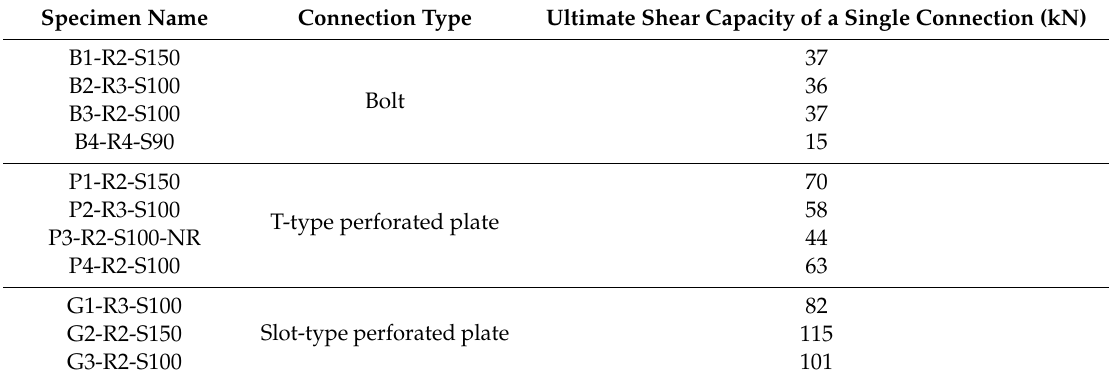
Table 2. Ultimate shear capacity of a single